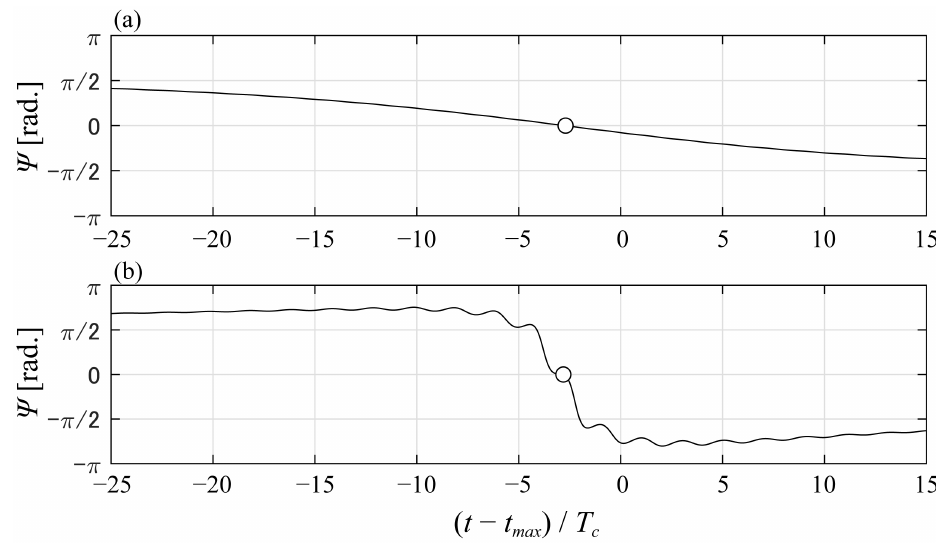
Figure 16. Temporal evolution of Ψ for the modulated wave train at approximately the time of the maximum crest height ( t = t max ) for ( a ) a 0 k c = 0.08 and ( b ) a 0 k c = 0.105. Circles indicate the times at which Ψ = 0.